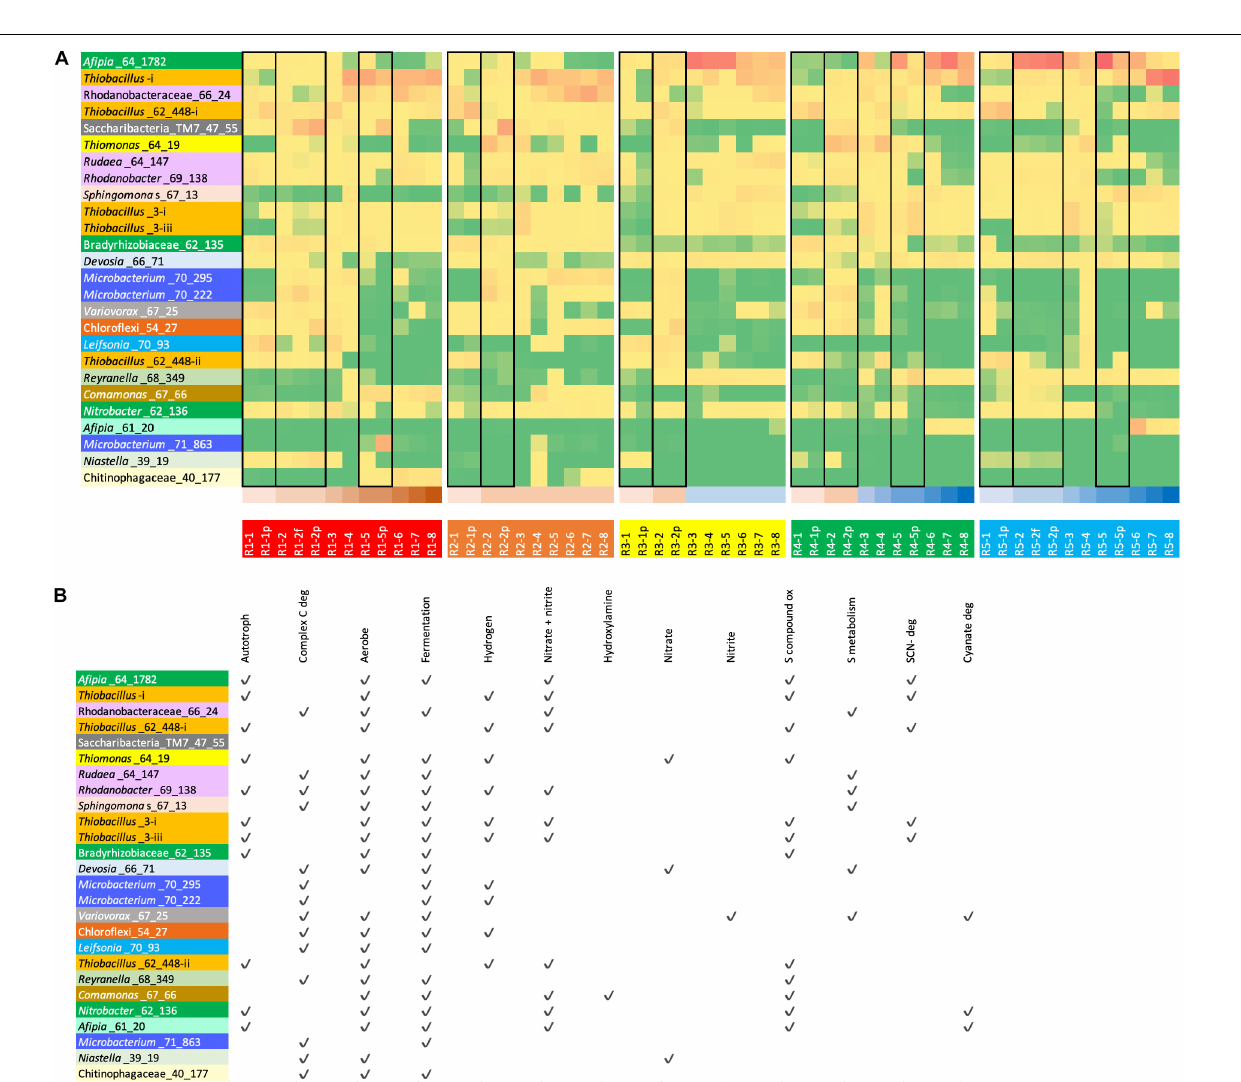
FIGURE 2 | (A) read mapping-based relative abundance of (high red, low yellow to green; see Supplementary Table 4 ) of the 26 most abundant organisms (rows) in R1 (molasses SCN ramp reactor, shown in shades of brown at the bottom of the table) and/or R5 (SCN ramp reactor without molasses, i.e., “water” reactor, shown in shades of blue at the bottom of the table) across all reactors. Genomes are colored by taxonomic grouping. For the full names of bacteria see (B) Black boxes group together samples from the same time point (biofilm and p = planktonic and f = floc sample). (B) Overview of functionalities encoded in the 26 genotypes representing the most abundant organisms in R1 and/or